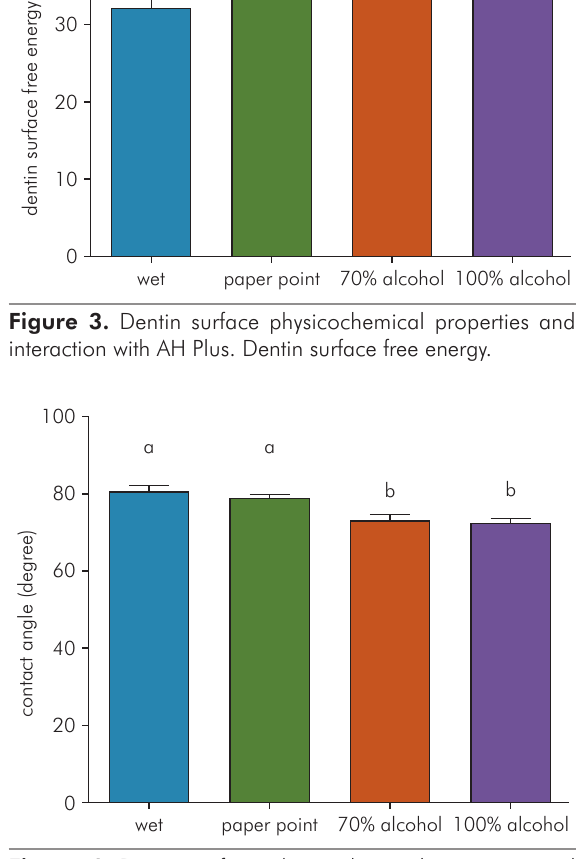
Figure 4. Dentin surface physicochemical properties and interaction with AH Plus. Contact angle between AH Plus sealer and the root canal